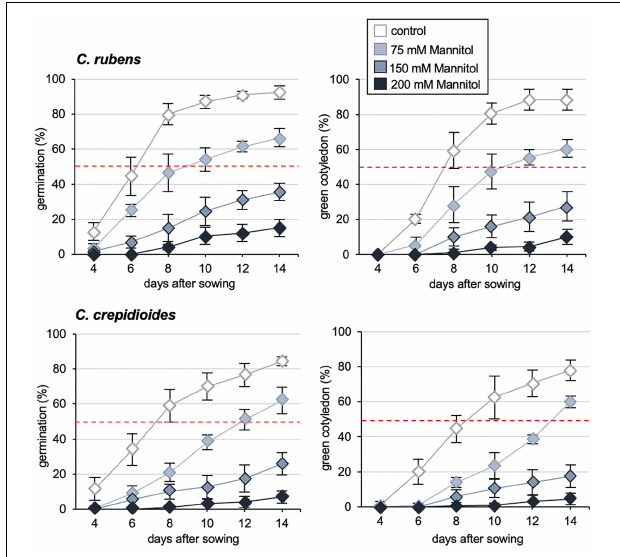
FIGURE 4 | Crassocephalum crepidioides shows increased resistance to Mannitol. Response of C. rubens Mali and C. crepidioides Ile-Ife to externally applied Mannitol in terms of germination capacities and cotyledon greening. Fifty seeds of each accession were plated on 1/2 MS medium without (control) or with 0, 75, 150, and 200 mM of Mannitol and incubated in 16-h 30 µ mol m − 2 s − 1 white light/8-h dark cycles at a temperature of 25 ◦ C. Seed germination (left graphs) was defined as radicle emergence from the seeds coat. Cotyledon greening (right graphs) was defined as fully developed, green cotyledons. The means and SDs are